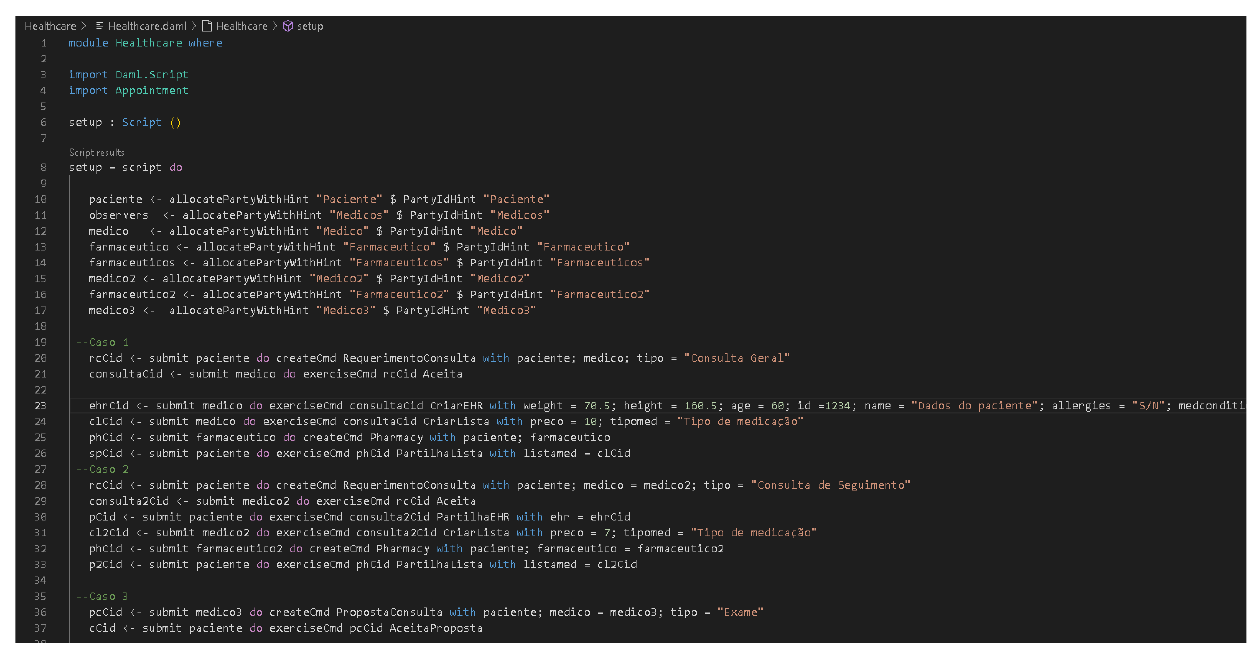
Figure 4. DAML code of the smart